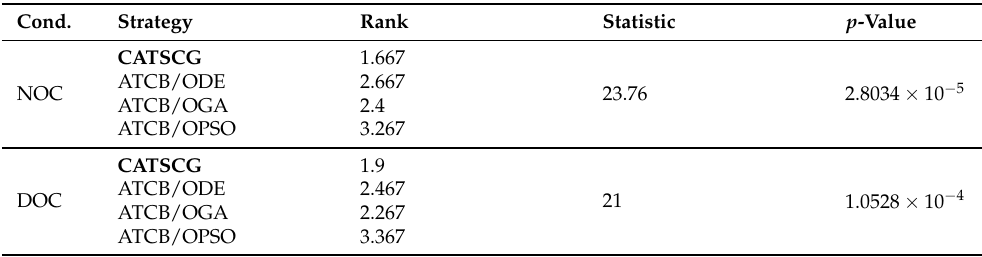
Table 7. Results of the multi-comparative Friedman test over the values of ISE for the adaptive controller tuning.